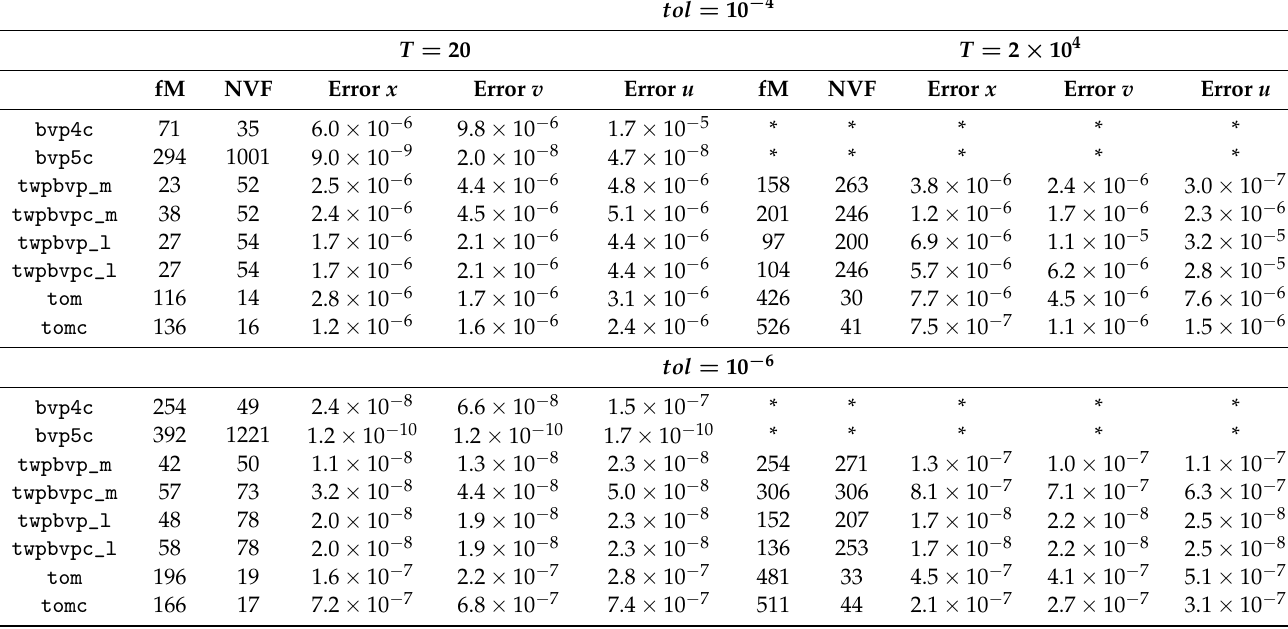
Table 1. Nonlinear Mass spring: final mesh (fM), total number of vectorized function evaluation (NVF) and mixed errors for x , v , u . The solution is computed starting from an initial mesh with 16 equidistant points. tol = 10 − 4 T = 20 T = 2 × 10 4